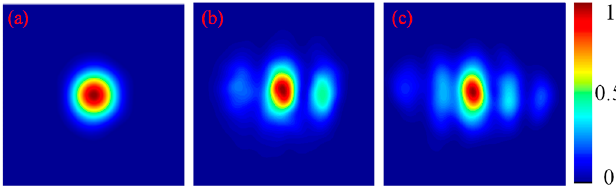
Figure 4. Measured intensity profiles of Hermite-Gaussian-like modes in ( a ) TELM 00 ; ( b ) TELM 20 and ( c ) TELM 40 . Sensors 2016 , 16 , 2014 10 of 15